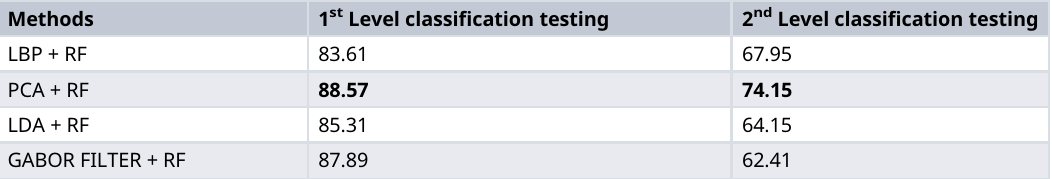
Table 6. Experimental results of RF variants. The best results are highlighted in bold.